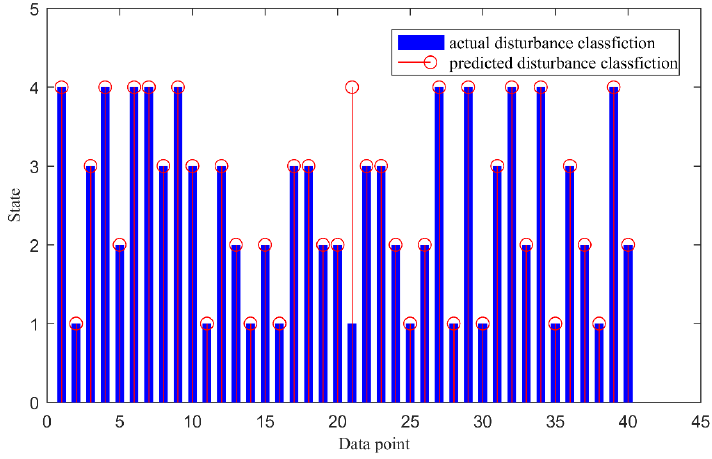
Figure 28. The BP classification diagram of the value of the components decomposed by MBMD calculated by CMFE.